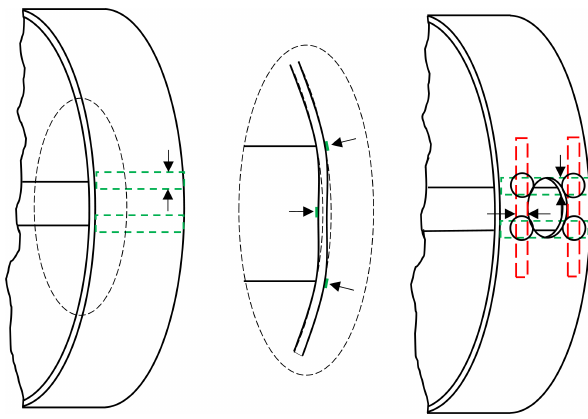
Figure 1: Schematic illustrating the strain concentration from bend- ing in a split disk sample in green squares and lines and the further concentration introduced with a hole. Arrows and circles further highlight the strain